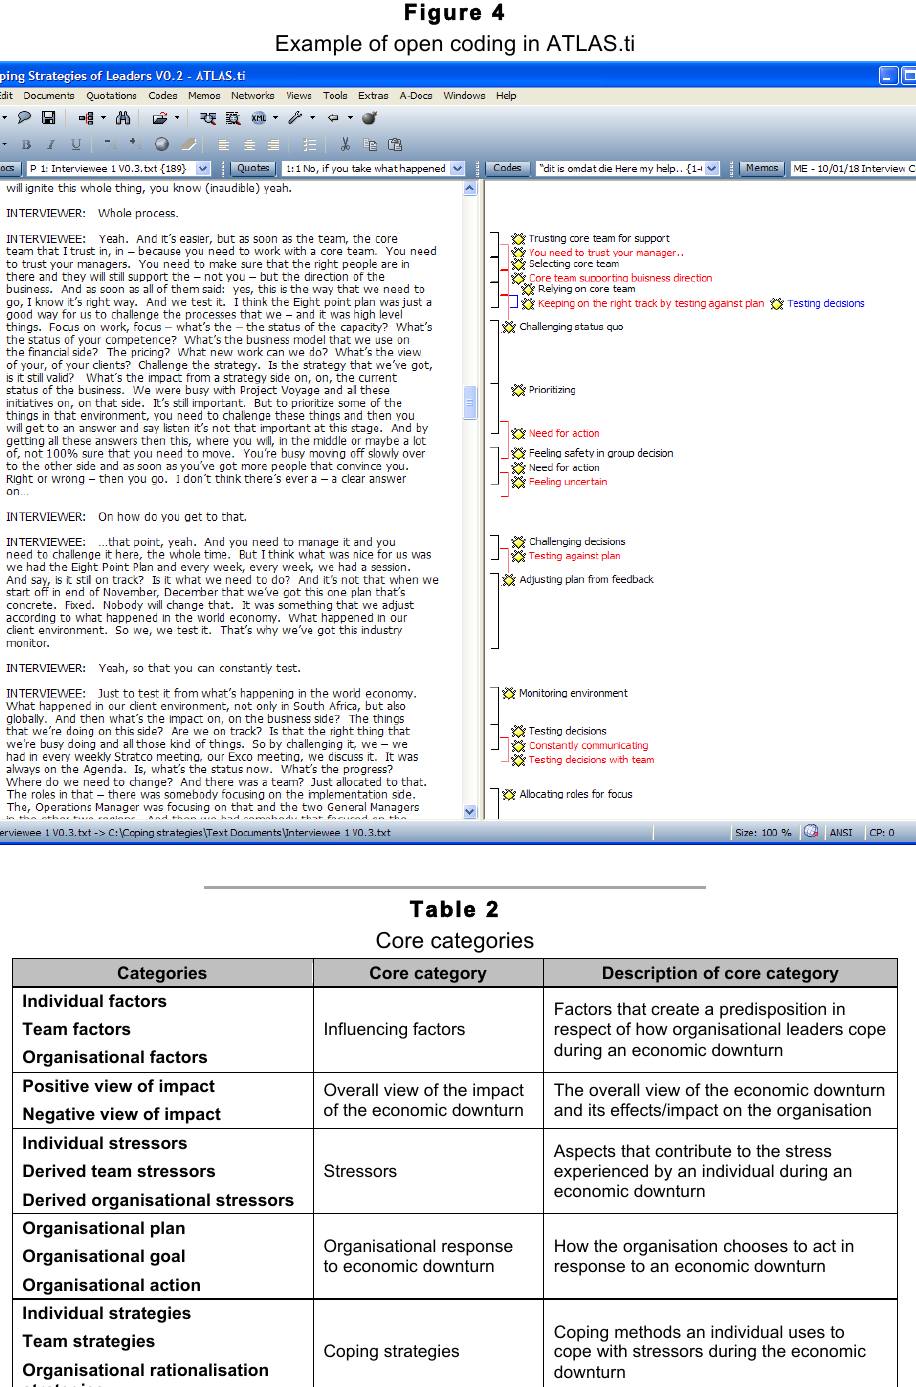
Example of open coding in